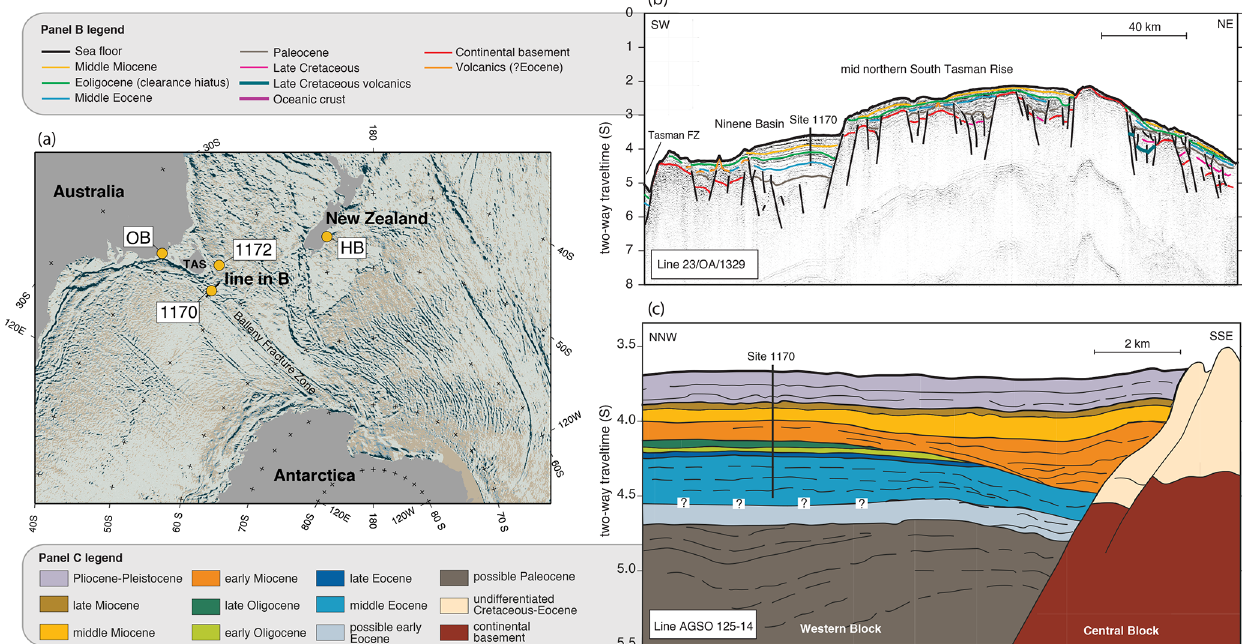
Figure 2. Tectonic setting of ODP Site 1170 and other studied sites. (a) Present-day map of the Australo-Antarctic sector of the Southern Ocean, with present-day locations of sites and sections used in this study as yellow circles (ODP Site 1170; ODP Site 1172; OB, Otway Basin; HB, Hampden Beach). NW–SE structural trends mark the direction of rifting between Australia and Antarctica, clearly visible in the (labeled) Balleny Fracture Zone. Seismic profile line 23/OA/1329, as shown in panel (b) , is drawn as a thick black line. Seismic profile line AGSO125-14 is not drawn due to its small scale. Adapted from Bijl et al. (2013b) and Cande and Stock (2004). (b) Interpreted SW–NE seismic profile (line SO36-58) across the South Tasman Rise, illustrating the Site 1170 location in a graben structure. Profile and interpretation adapted from Hill and Moore (2001). (c) Interpreted NNW–SSE seismic profile (line AGSO125-14) across the South Tasman Rise, including Site 1170, illustrating laterally thinning seismic layers of interpreted middle Eocene age. Profile and interpretation adapted from Exon et al.